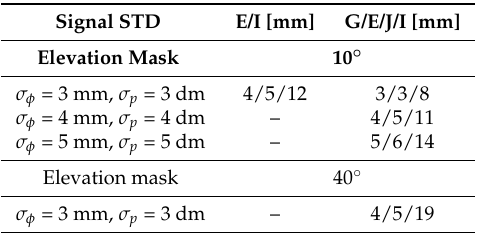
Table 5. Average ambiguity-fixed formal standard deviations of the baseline errors for CUAU-CUCU in Galileo/IRNSS and GPS/Galileo/QZSS/IRNSS-combined cases. The MGEX combined broadcast ephemeris on DOY 224, 2018 was used for the computation. The standard deviations (STD) are given in the format of North/East/Up